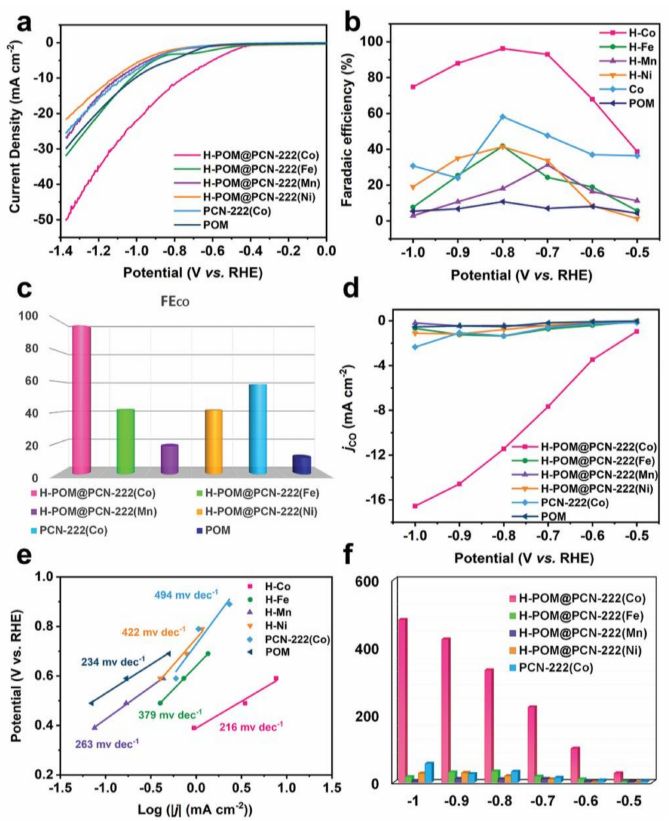
Figure 2. Electrocatalytic CO 2 –RR performances of H − POM@PCN − 222 (Co), H − POM@PCN − 222 (Fe), H − POM@PCN − 222 (Mn), H − POM@PCN − 222 (Ni), PCN − 222 (Co), and POM. ( a ) Linear sweep voltametric scans. ( b ) Faradaic efficiencies for CO with different metals and at different potentials. ( c ) Maximum FECO for six samples at − 0.8 V (vs RHE). ( d ) CO current density at different potentials. ( e ) Tafel plots. ( f ) The turnover frequency for different metals and PCN − 222 (Co). Re − printed with permission from Ref. [70]. Copyright 2021,